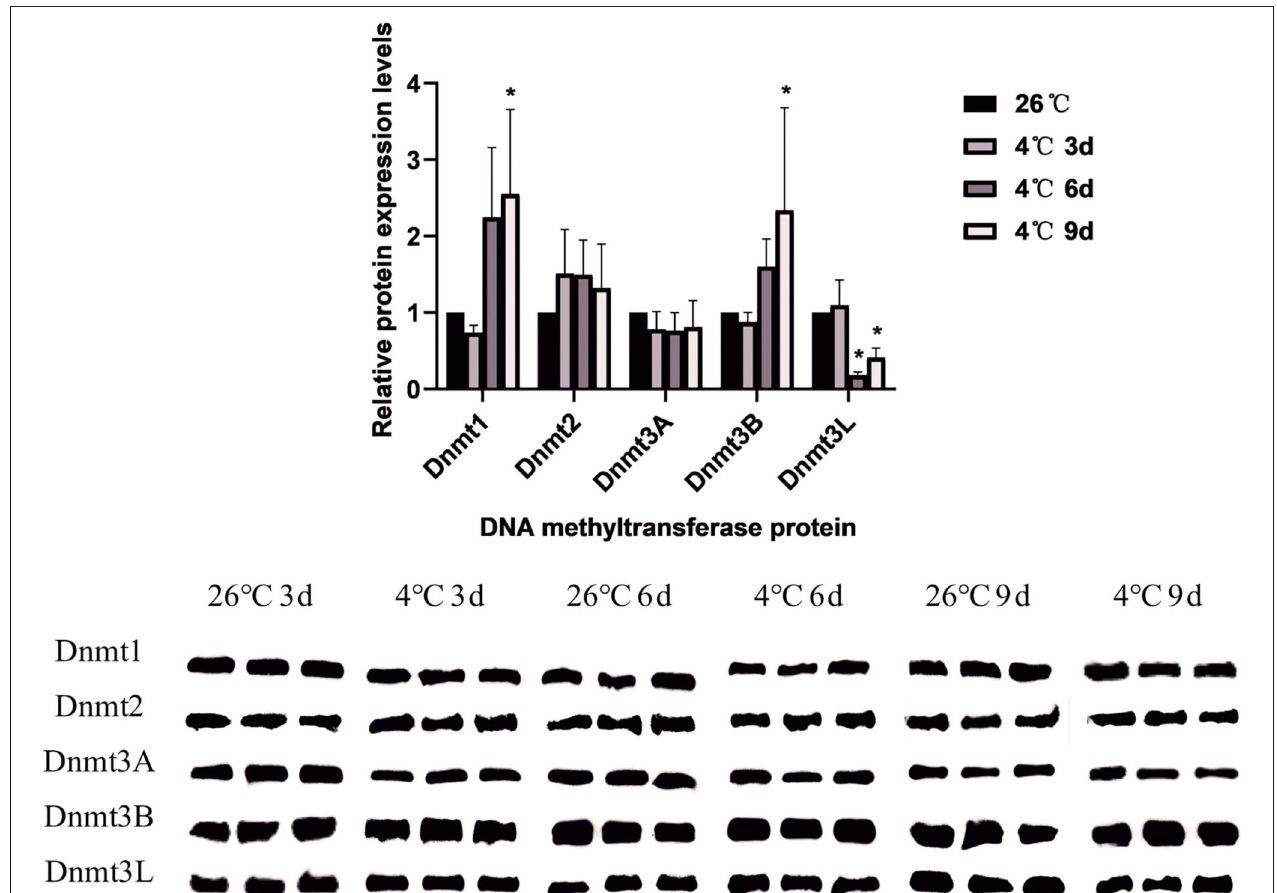
FIGURE 8 | The relative protein expression of Dnmts in H. longicornis after cold treatment. The relative level of the expression of DNA methyltransferase proteins were calculated, and the expression in the control group served as the reference, which was set at 1. The results are expressed as the means ( n = 3) ± SEM. The asterisks above bars indicate a significant difference based on one-way ANOVA followed by Turkey’s test, * P <